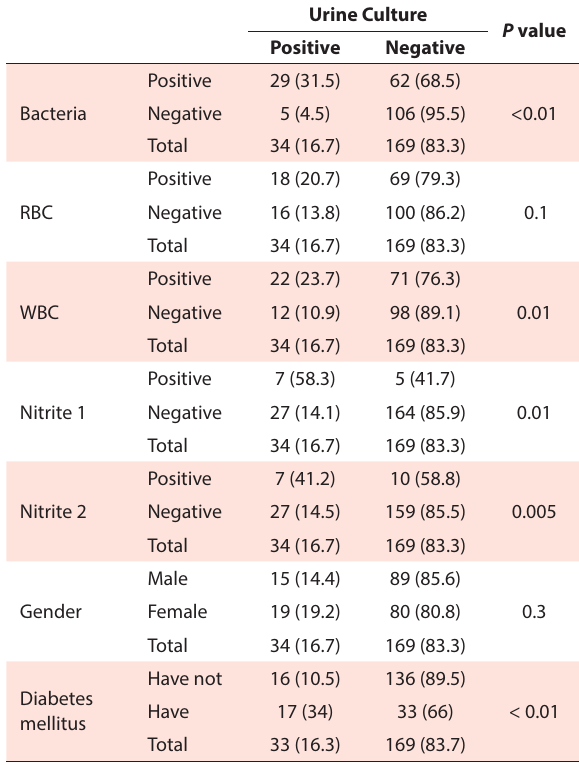
Table 3. Evaluation of the relationship between urine culture result and gender, diabetes mellitus, bacteria, RBC, WBC, nitrite 1 and nitrite 2 Urine Culture